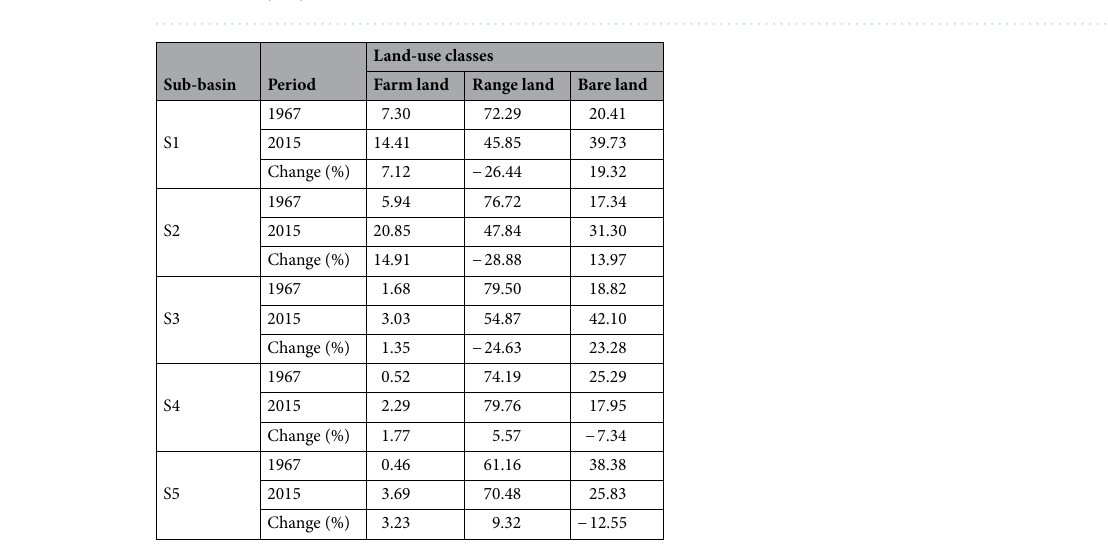
Figure 6. M–K test analysis change point of the (P) precipitation; (R) runoff; (BFI) baseflow index in the subbasins S1, S3, and S5 of the Dez River.